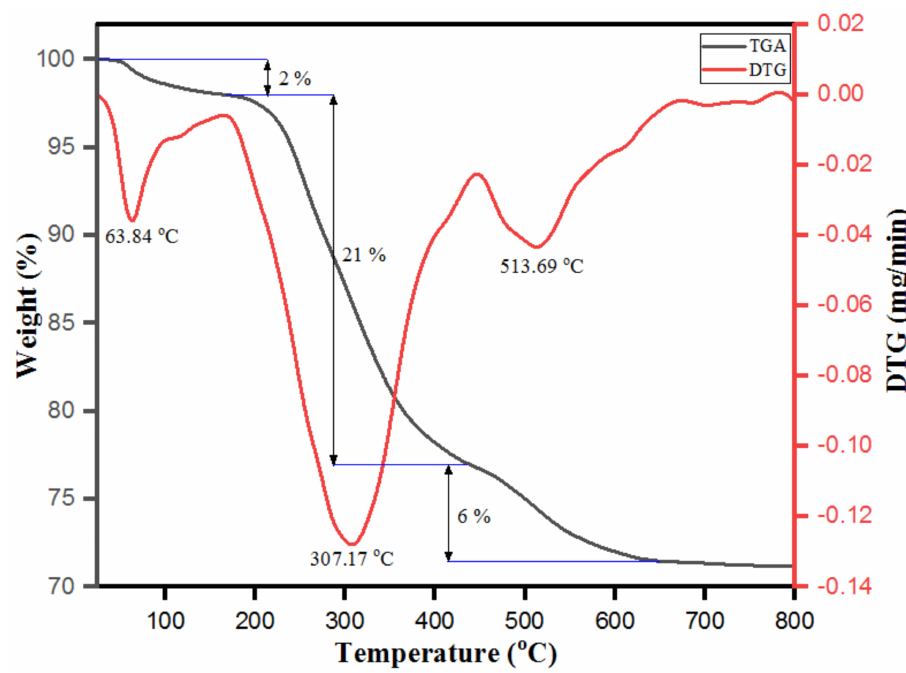
Figure 8. Thermogravimetric analysis (TGA) and derivative thermogravimetric (DTG) curves of Ag-Cu bimetallic